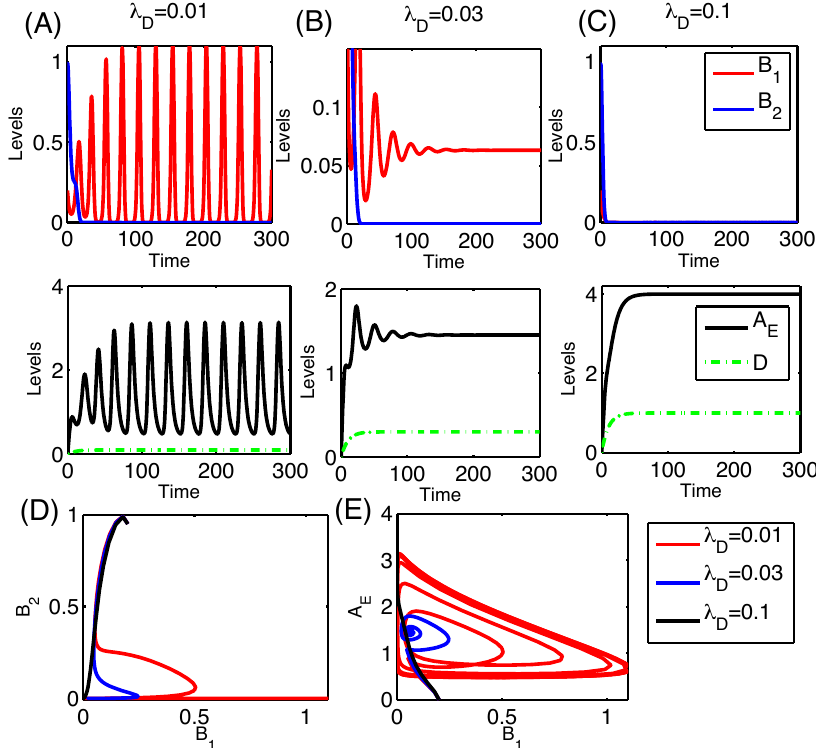
Figure 12. Dynamics of system in response to constant drug injection in the presence of time delays ( τ 1 = τ 2 = 3.5) on immune response in the two-species model (52)–(55). ( A ) Small amount of drug injection ( λ D = 0.01) still results in the oscillatory behaviors of both harmful bacteria ( B 1 ) and immune cytokines ( A E ) and the extinction of good bacteria; ( B ) for an intermediate level of injection ( λ D = 0.03), this oscillation disappears, and the system leads to the infection-persist state = 0, B s > 0); ( C ) large amount of injection ( λ = 0.1) significantly enhances the immune activity ( B s D 2 1 = 0); ( D ) trajectories of bad ( B = 0, B s and removes both good and bad pathogens ( B s 1 ) and good 2 1 ( B 2 ) bacteria for various drug injection rates ( λ D = 0.01,0.03,0.1); ( E ) trajectories of bad bacteria ( B 1 ) and immune activity ( A E ) for various drug injection rates ( λ D = 0.01,0.03,0.1). Initial condition: B 1 ( 0 ) = 0.2, B 2 ( 0 ) = 0.95, A E ( 0 ) = 0.0, D ( 0 ) = 0. All other parameters are fixed as in Table 4 (Type